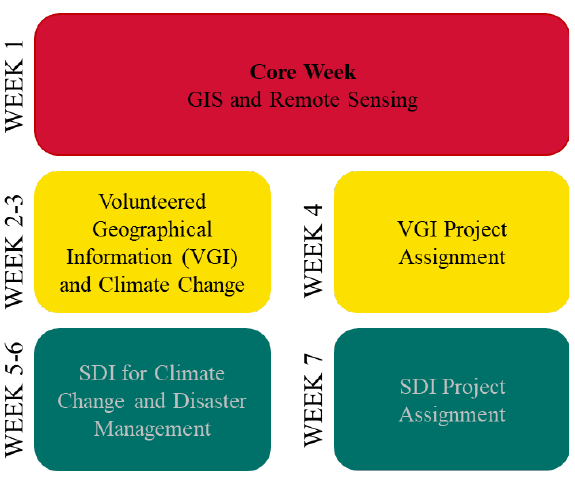
Figure 2. Weekly course structure